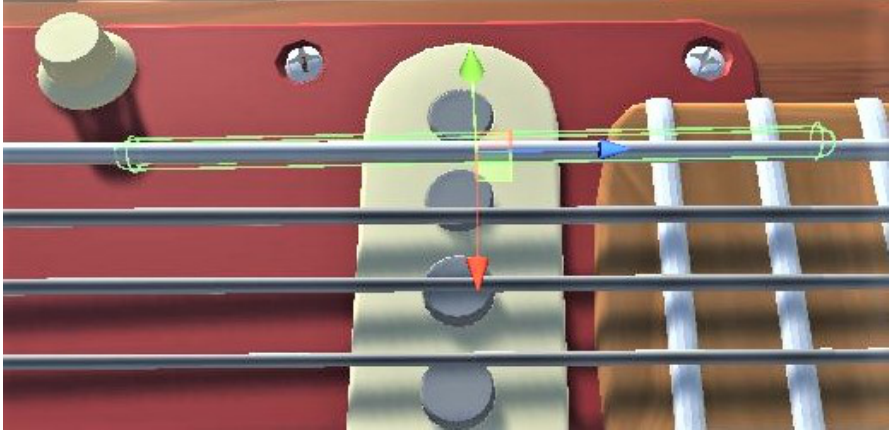
Figure 7. A Capsule collider attached to a string. The green, red, and blue arrows depict the orientation of the capsule